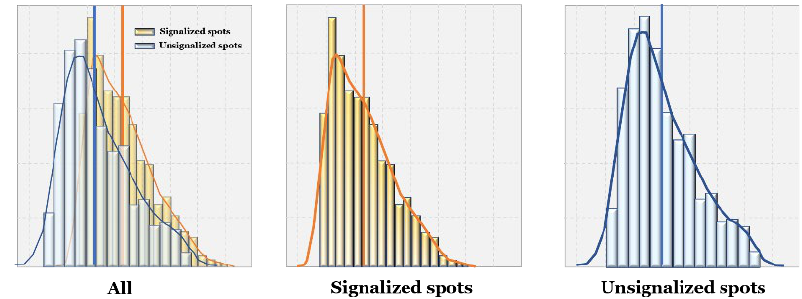
Figure 14. Distributions of PSMs in signalized and unsignalized spots.